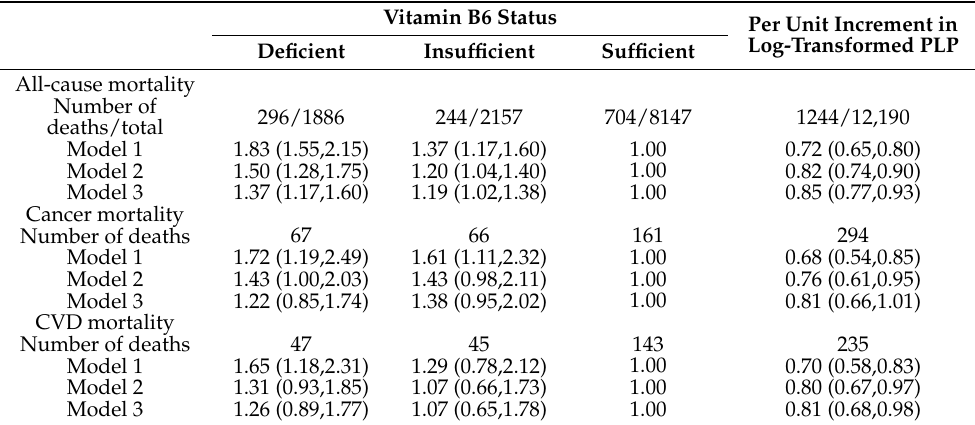
Table 2. HRs (95% CIs) of all-cause and specific-cause mortality according to serum vitamin B6 concentrations.